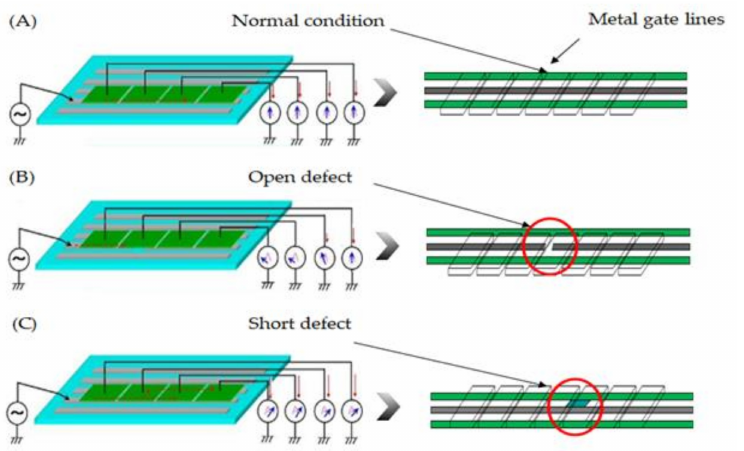
Figure 1. A topology of open/short defects appearing on the thin-film transistors (TFT) display, ( A ) normal condition, ( B ) open defect, and ( C ) short